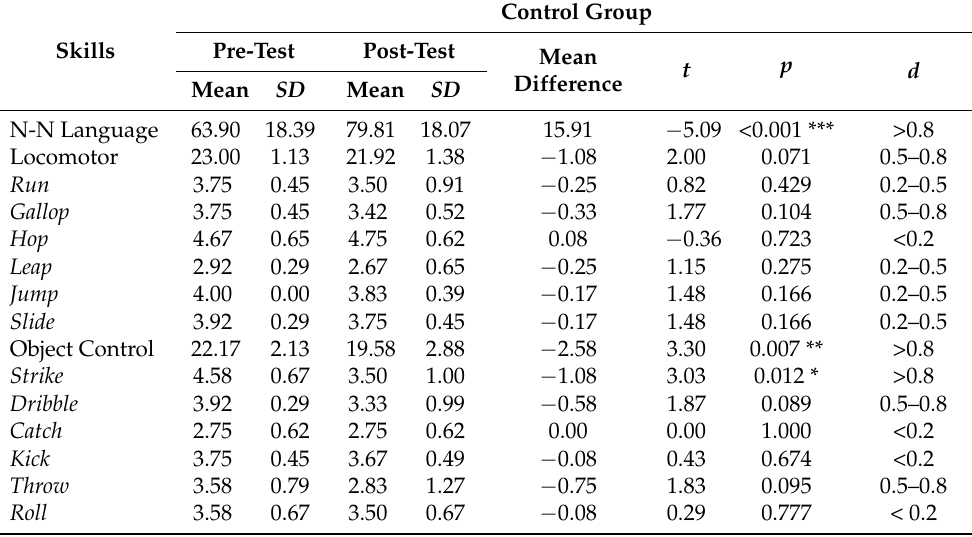
Table 2. Mean and standard deviation of the control and experimental groups in the pre- and post- tests. Mean differences were calculated as the pre-test scores subtracted from the post-test scores; therefore, a positive result shows progress and a negative result shows